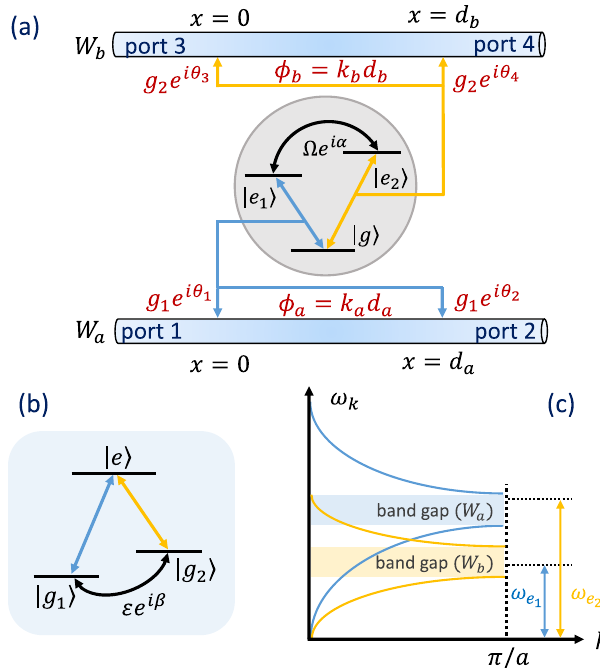
Fig. 5 Schematic con fi guration of the three-level giant atom coupled to double waveguides. a ∇ -type atom: the waveguide W a ( W b ) is coupled to (cid:11) (cid:11) (cid:12) (cid:12) (cid:11) (cid:11) the transition g j i $ e 1 ( g j i $ e 2 ) at two separated points. The excited (cid:11) (cid:11) (cid:12) (cid:12) (cid:11) (cid:11) states e 1 and e 2 are coupled to a coherent fi eld Ω e i α . b Δ -type atom: W a (cid:11) (cid:11) (cid:12) (cid:12) (cid:11) (cid:11) ( W b ) is coupled to g 1 $ e j i ( g 2 $ e j i ) at two separated points. Two (cid:11) (cid:11) (cid:12) (cid:12) (cid:11) (cid:11) ground states g 1 and g 2 are coupled to a coherent fi eld ε e i β . c Band structures of two PCWs used to implement our